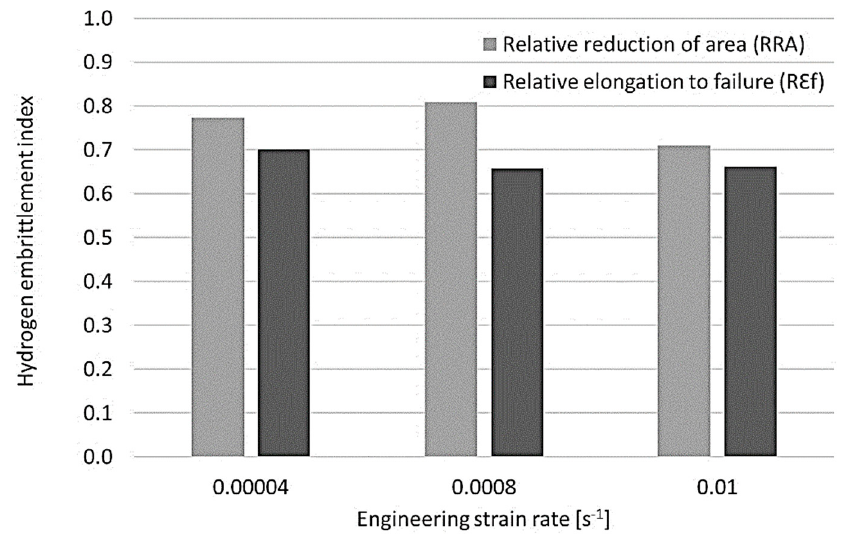
Figure 7. Influence of the nominal engineering strain rate on the RRA and R Ɛ f values according to ASTM G129 [31] for the investigated CP1000 steel sheet. Table 3. Mechanical properties determined during tensile tests with different crosshead speeds in air and after hydrogen charging.